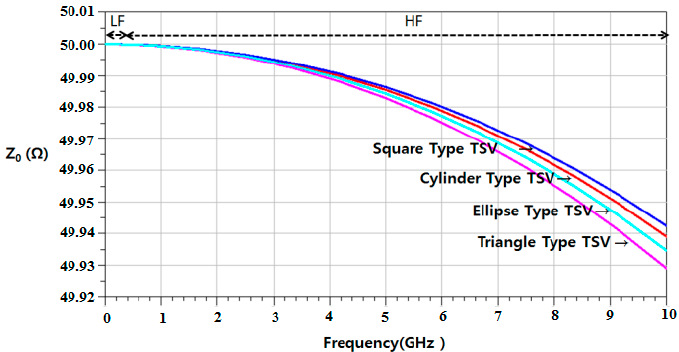
Figure 5. Characteristic impedance (Z 0 ) for different TSV shapes.